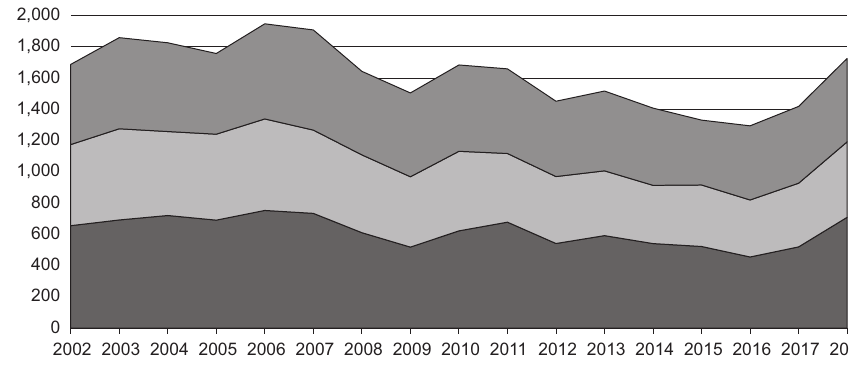
Fig. 6. The size of emigration from Wrocław in years 2002–2018 outside Dolnośląskie Voivodeship. Source: author’s own work based on the Demography